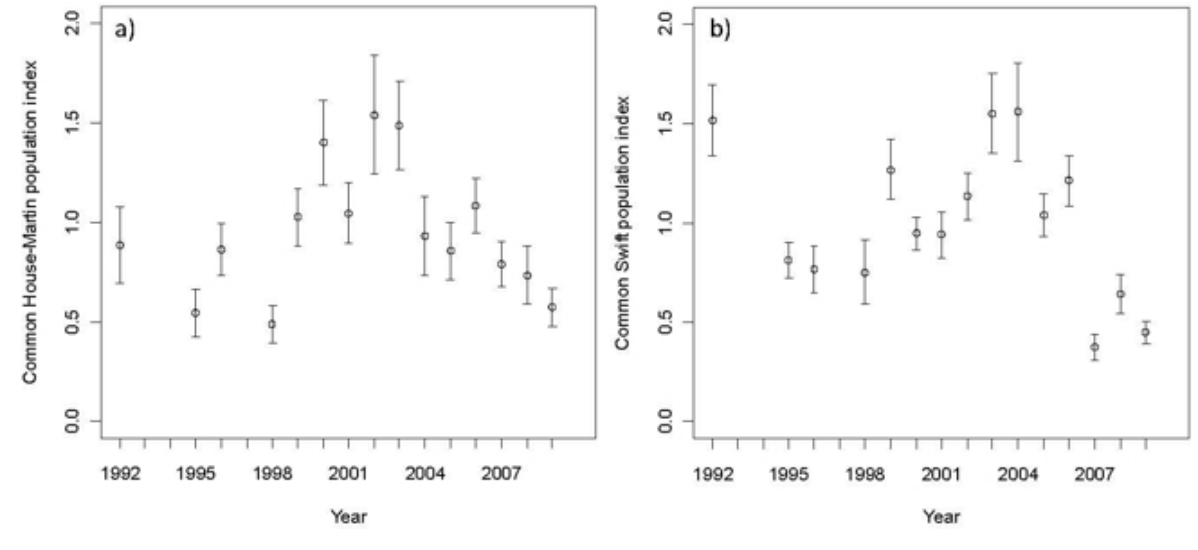
Fig. 1. Population indices of (a) Common House-Martin and (b) Common Swift. Bars represent bootstrapped standard